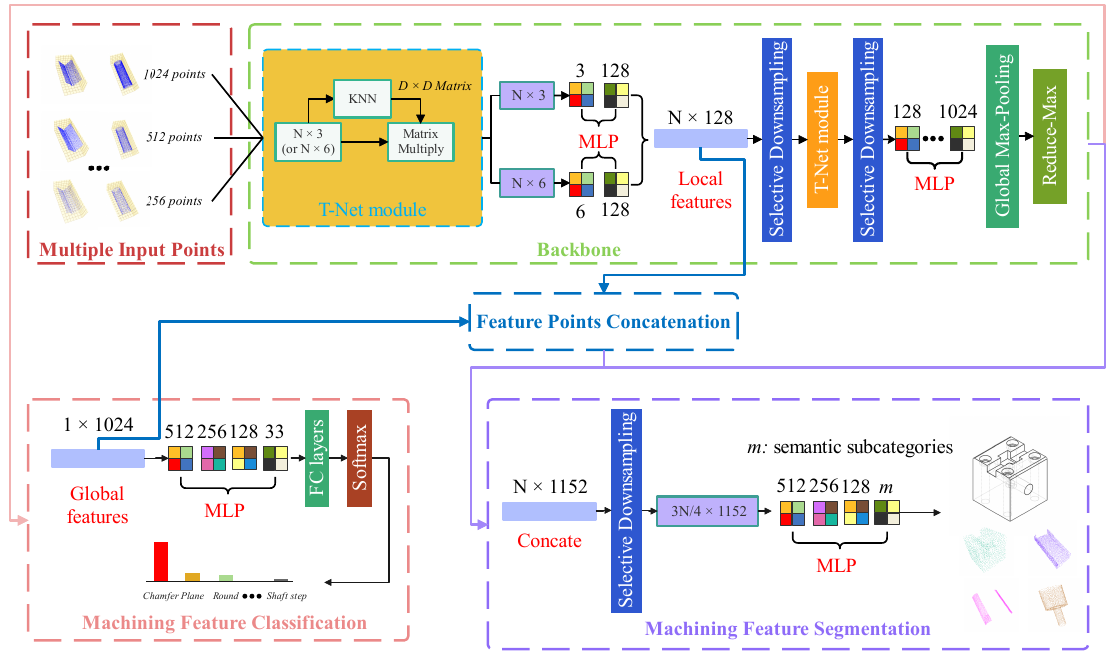
Figure 6. The structure of MFPointNet combining the classification network and segmentation network. In the backbone, after inputting the feature points into a T-Net module, the attribute of input points remains unchanged. MLP (3, 128) or MLP (6, 128) is convolved through a two-layer perceptron network [66] to obtain an N × 128 output feature point cloud. Only half of the original input points are inputted after the SDL module, obtaining an output feature of (N/2) × 128. This is then followed by a T-Net module to guarantee the rotational invariance of the input point. Then after an SDL module, the output point becomes (N/4) × 128. The (N/4) × 1024 output feature points are obtained by using four convolution layers, each with 128, 256, 512, and 1024 convolution kernels of size 1 ×